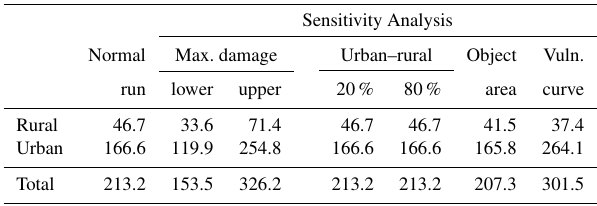
Table 8. Expected annual damage (in million USD in 2016 values) compared for the normal model setup and the modified parameters used in the sensitivity